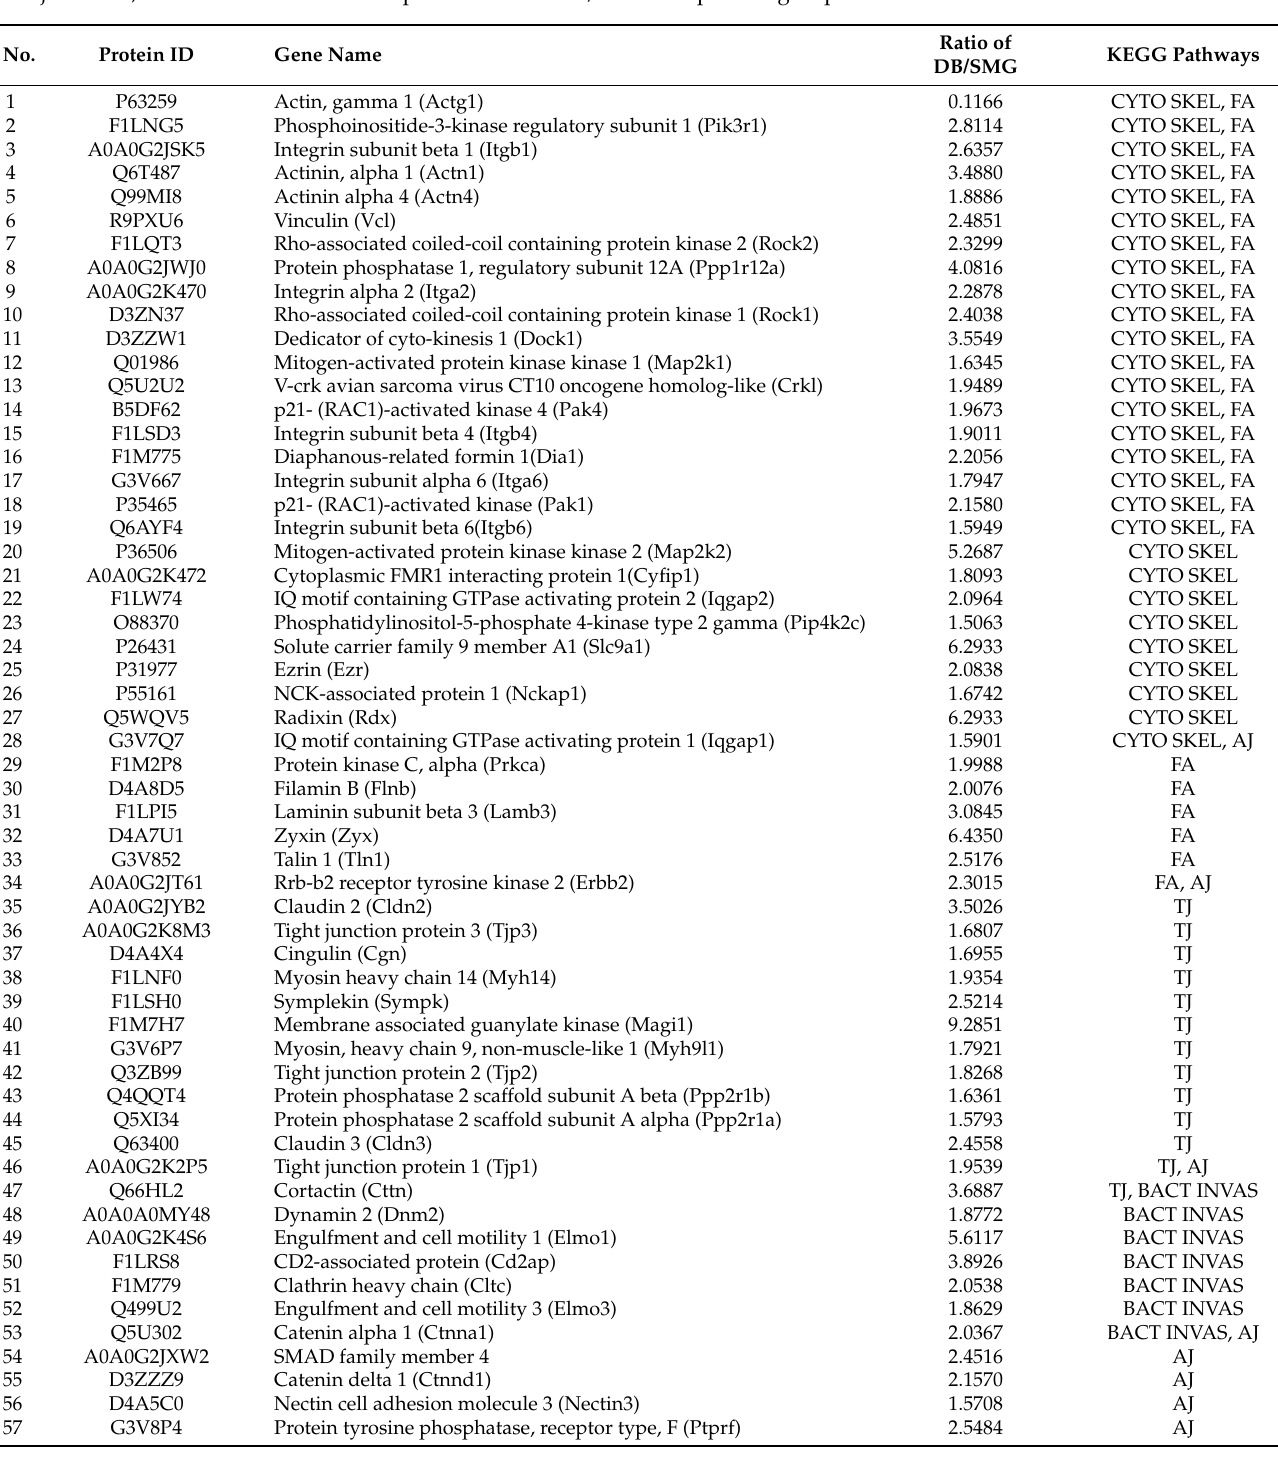
Table 1. DEPs in different KEGG pathways related to focal adhesion, regulation of cytoskeleton, adherens, and tight junctions, and bacterial invasion in epithelial cell in DB/SMG comparison